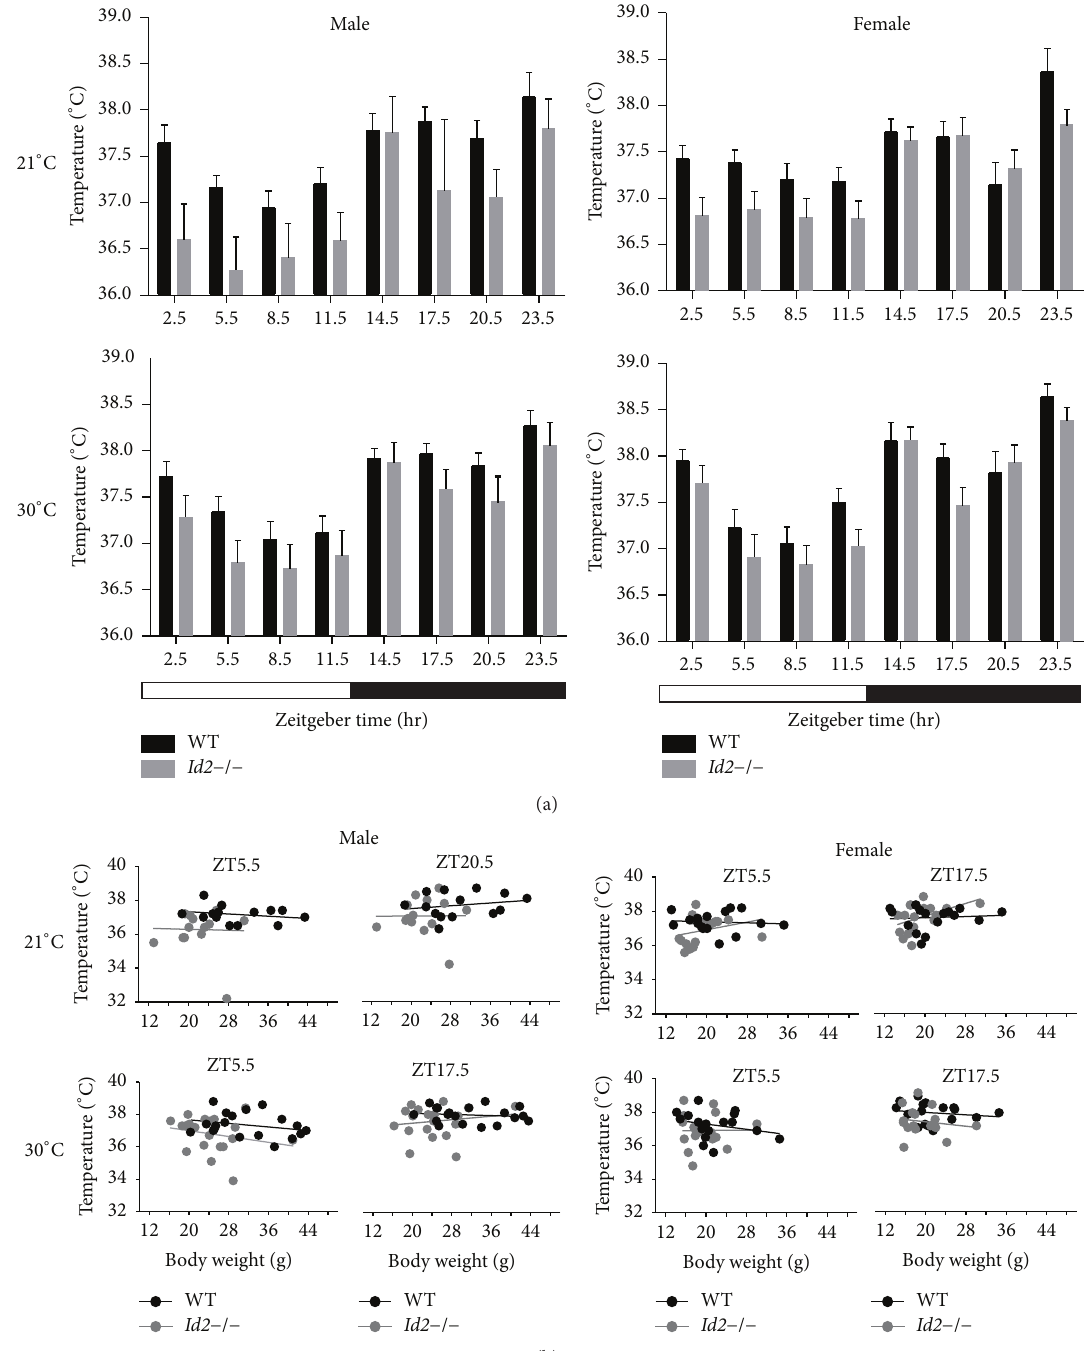
Figure 1: Sex-specific regulation of body temperature in Id2 − / − mice. (a) Body temperature measurements of WT and Id2 − / − male (left) and female (right) mice under normal temperature (upper panel) or thermoneutral temperature (lower panel) over 24 hrs. Values are mean ± SEM. Two-factor ANOVA was performed. ANOVAs revealed significantly lower body temperatures for both male and female Id2 − / − mice compared to WT mice. The genotypic effect was independent of the prevailing ambient temperature. (b) Upper: regression analysis of body weight to body temperature of WT and Id2 − / − mice under normal ambient temperature (left: male at ZT5.5 and ZT20.5; right: female at ZT5.5 and ZT17.5). Lower: regression analysis of body weight to body temperature of WT and Id2 − / − mice under thermoneutral temperature conditions (left: male at ZT5.5 and ZT17.5; right: female at ZT5.5 and ZT17.5). Values are individual animal body temperatures and their respective measures of body mass. Note that no linear regression was found to be significant (n.s.), indicating that body mass does not predict body temperature for any group analyzed, examined under either 21 ∘ C or 30 ∘ C environmental